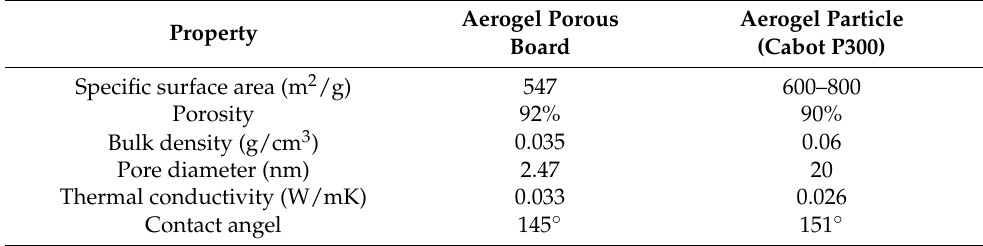
Table 2. Comparison of the characteristics between the aerogel porous board and aerogel particle.